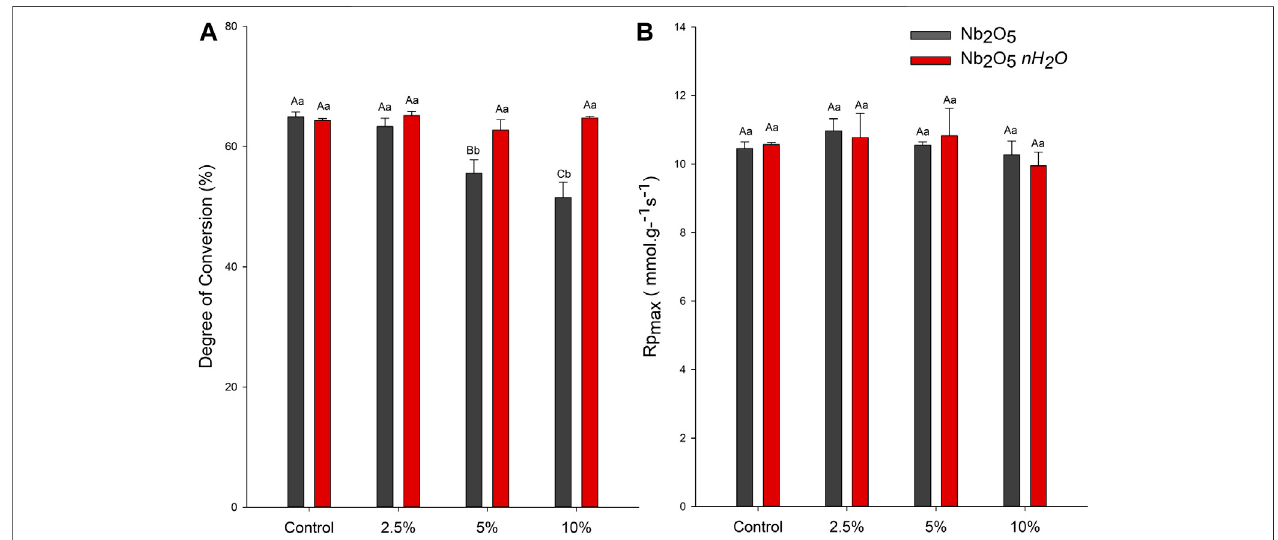
FIGURE4| Degreeofconversion(DC)andmaximumpolymerizationrate(RP max )ofdentaladhesives (A) Percentageofconvertedcarbon-carbondoublebondsof the dental adhesives after photoactivation via FTIR-ATR (B) RP max of the dental adhesives via DSC-PCA. Different capital letters indicate a statistically signi fi cant difference among the concentrations (0, 2.5, 5, and 10 wt%) for the same type of fi ller (Nb 2 O 5 or Nb 2 O 5 . n H 2 O) for the DC or RP max evaluation ( p < 0.05). Different lowercase letters indicate a statistically signi fi cant difference within the same concentration (0, 2.5, 5, or 10 wt%) comparing the different types of fi ller (Nb 2 O 5 or Nb 2 O 5 . n H 2 O) for the DC or RP max evaluation ( p < 0.05).